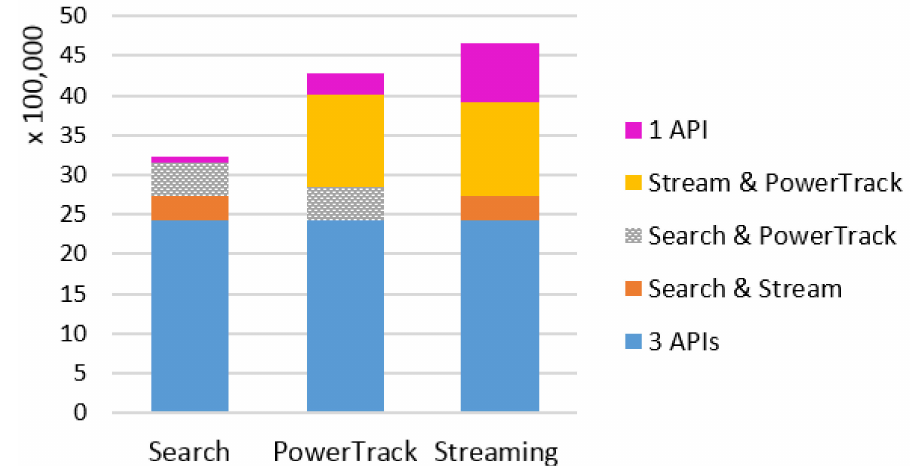
Figure 1. Number of tweets retrieved by each API, combining all three topics. Blue indicates the amount of tweets retrieved by all three APIs, yellow, textured gray, and orange indicate the amount retrieved by two APIs, and magenta indicates the amount of tweets unique to each API.